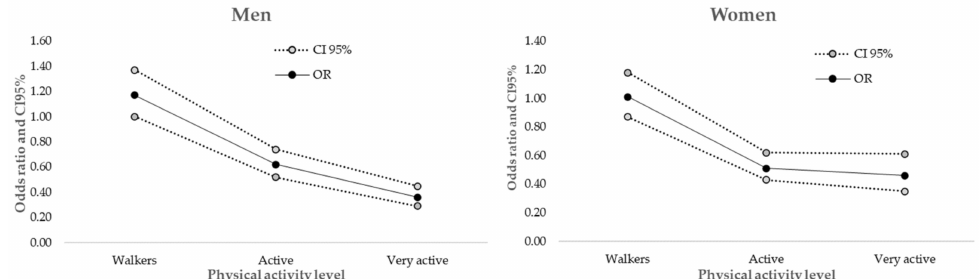
Figure 3. Risk of hypertension, according to physical activity level by